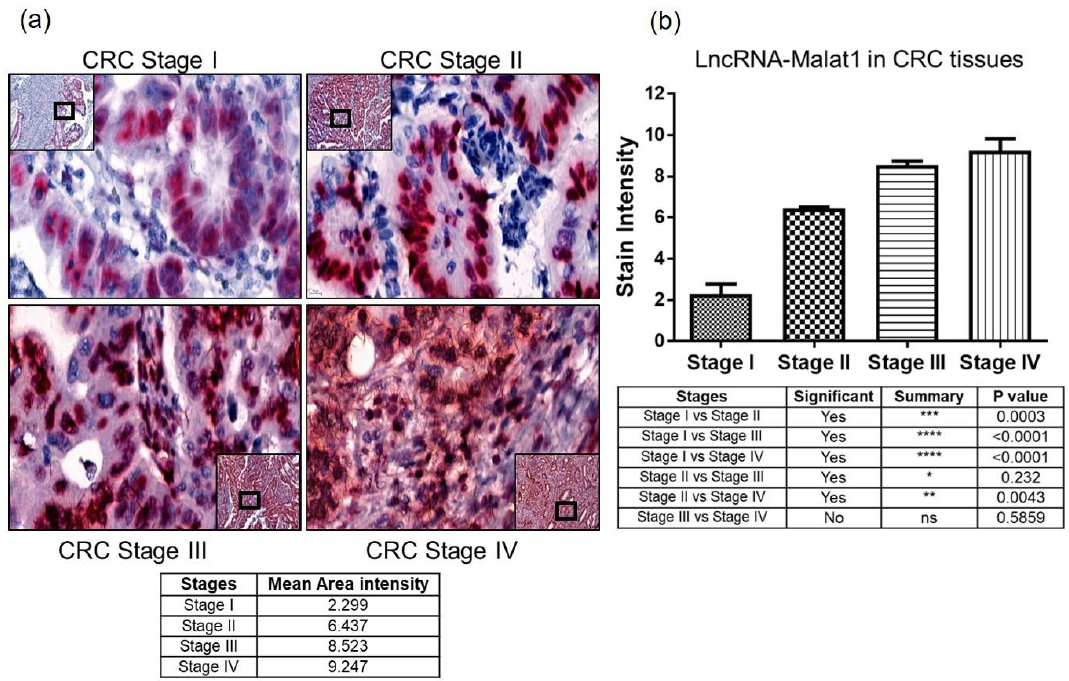
Figure 4. LncRNA-MALAT in different stages of colorectal cancer (CRC). Paraffin embedded different stages of colorectal cancer tissues were stained for lncRNA MALAT1 and quantitated for staining intensity. 60 CRC tissues, Stage I = 15; Stage II = 16; Stage III = 20; Stage IV = 9, were stained for lncRNA-MALAT1 ( a ) Stages I–IV CRC tissues show a differential stain for lncRNA MALAT1. Stain intensity correlates with the progression. ( b ) Quantitation of the lncRNA MALAT1 staining intensity was performed using Image J software. 10 × (inset) and 80 × magnification using CaseViewer 2.2 software, scanned and analyzed on Pannoramic 250 Flash III. Statistical analysis: One-way ANOVA and Tukey’ multiple comparison tests compare the mean of each column with the mean of other